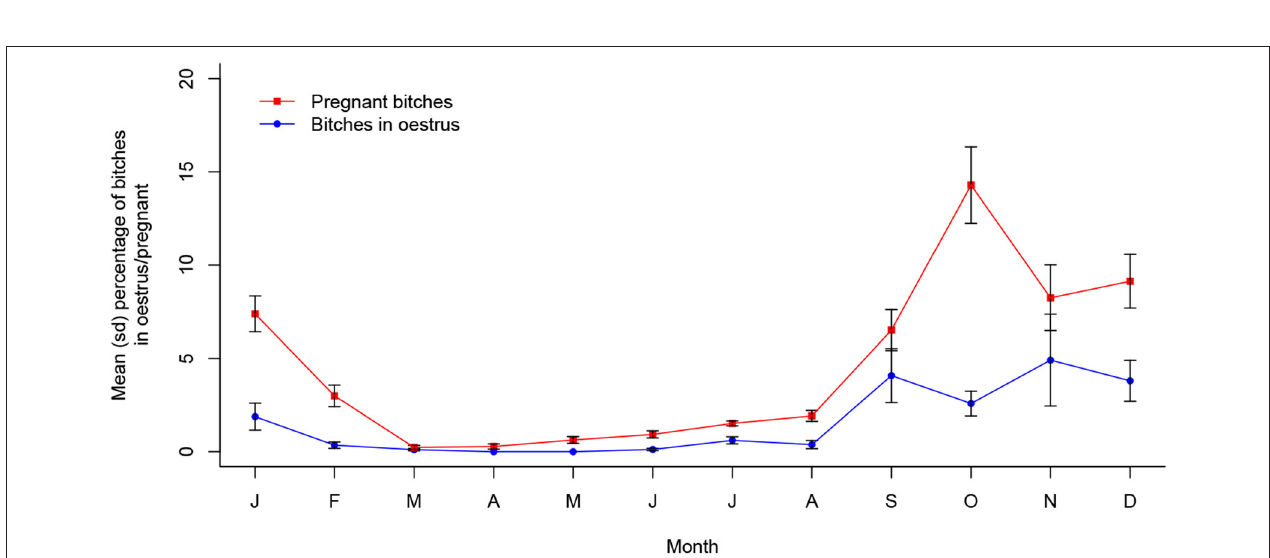
FIGURE 6 | Mean (sd) proportions of bitches in oestrus and pregnant in Vadodara, India between 2017 and 2021 ( n = 8,860).